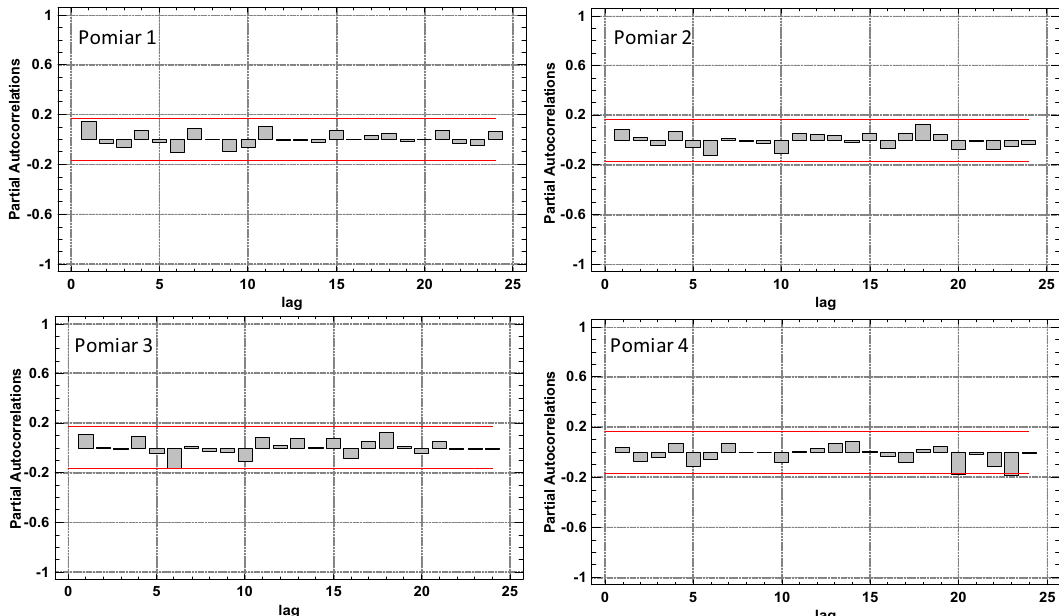
Figure 14. Estimated partial autocorrelations for various lags for the number of defects (density) in 1-m segments of the 7–8 belt section, for the consecutive scans 5,42 [Statgraphics Centurion Version 18.1.06 64-bit version (academic license of Wrocław University of Science and Technology), https:// www. statg raphi cs. com/].